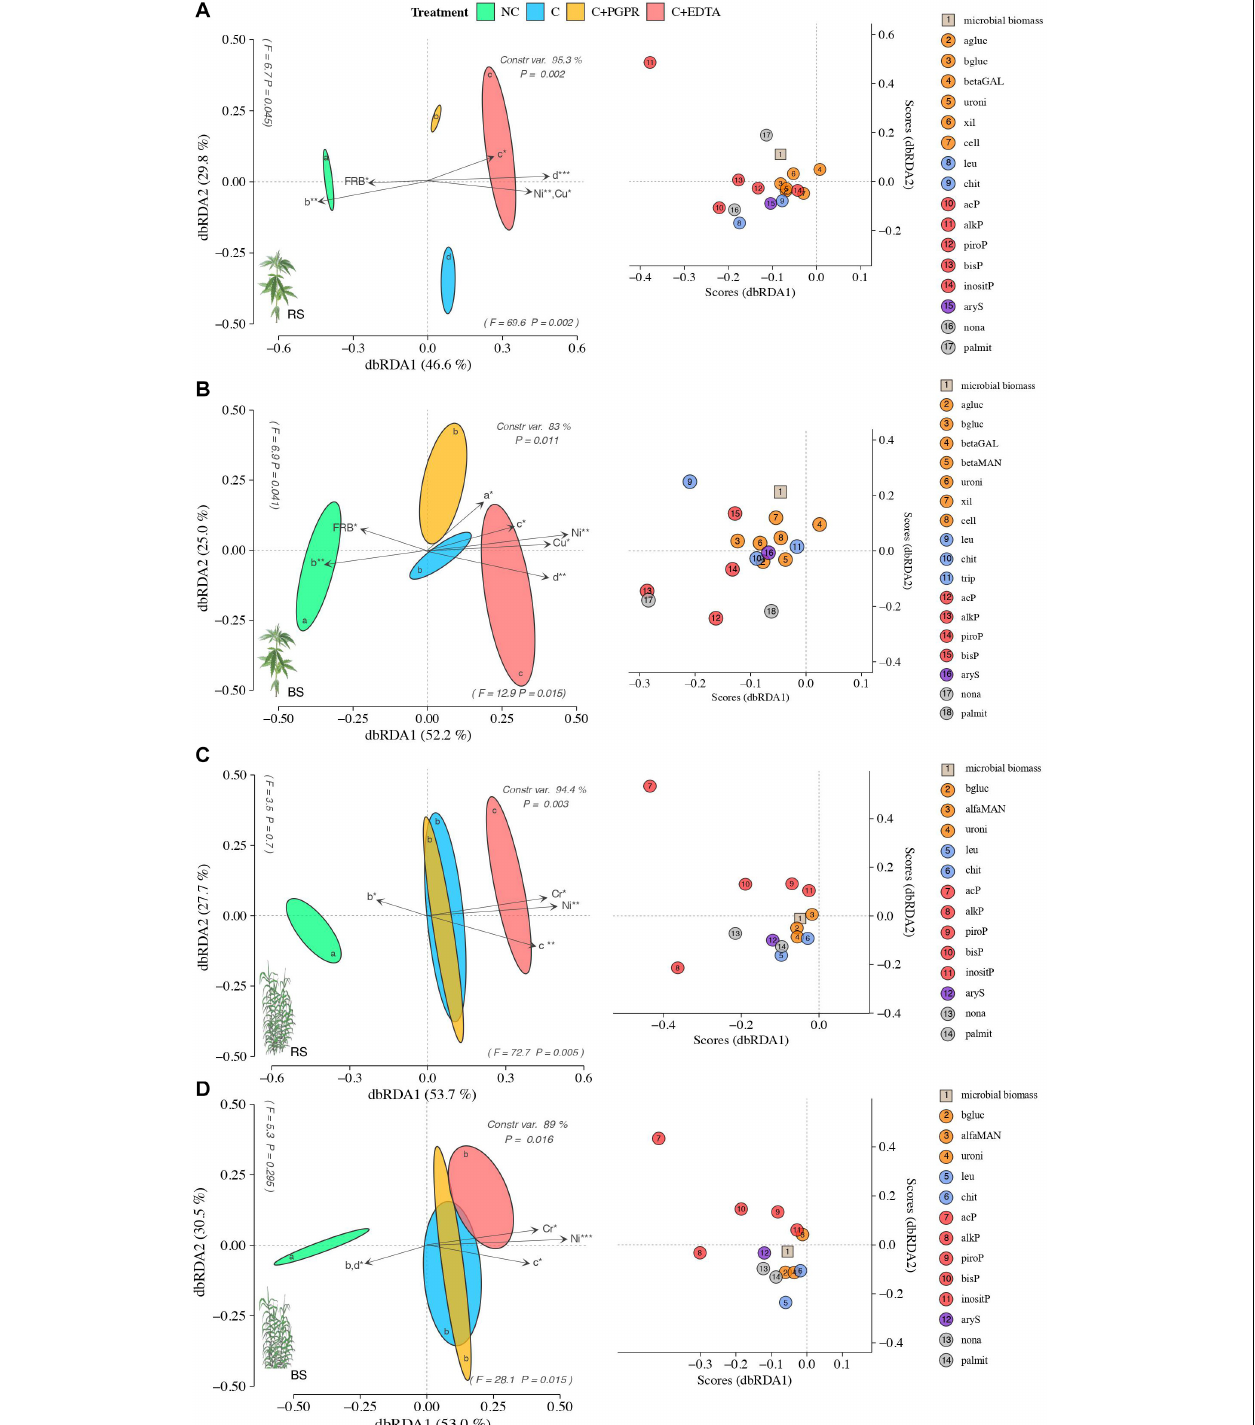
Frontiers in Microbiology |